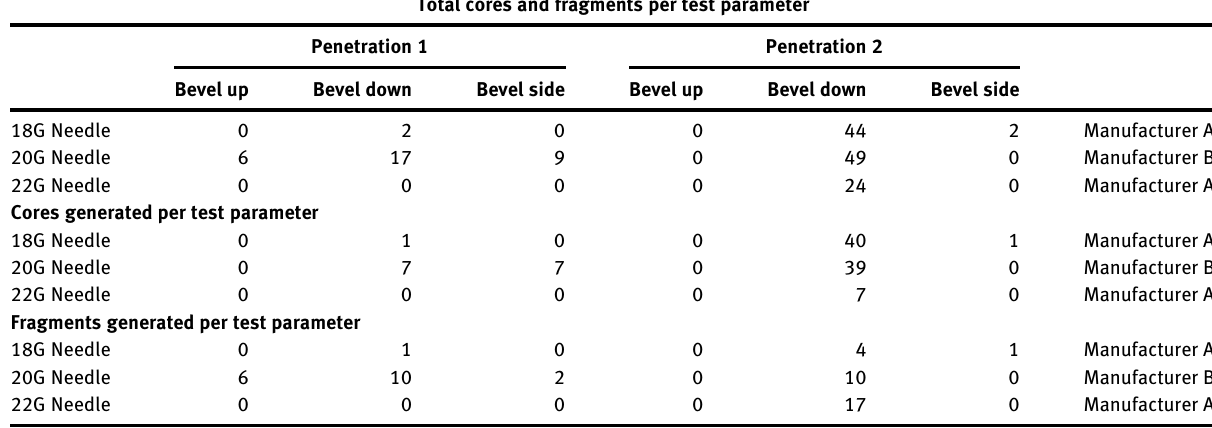
Table  : Number of cores and fragments generated.